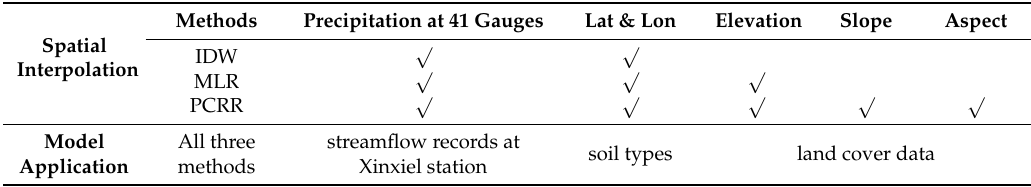
Table 1. Data for interpolation and model